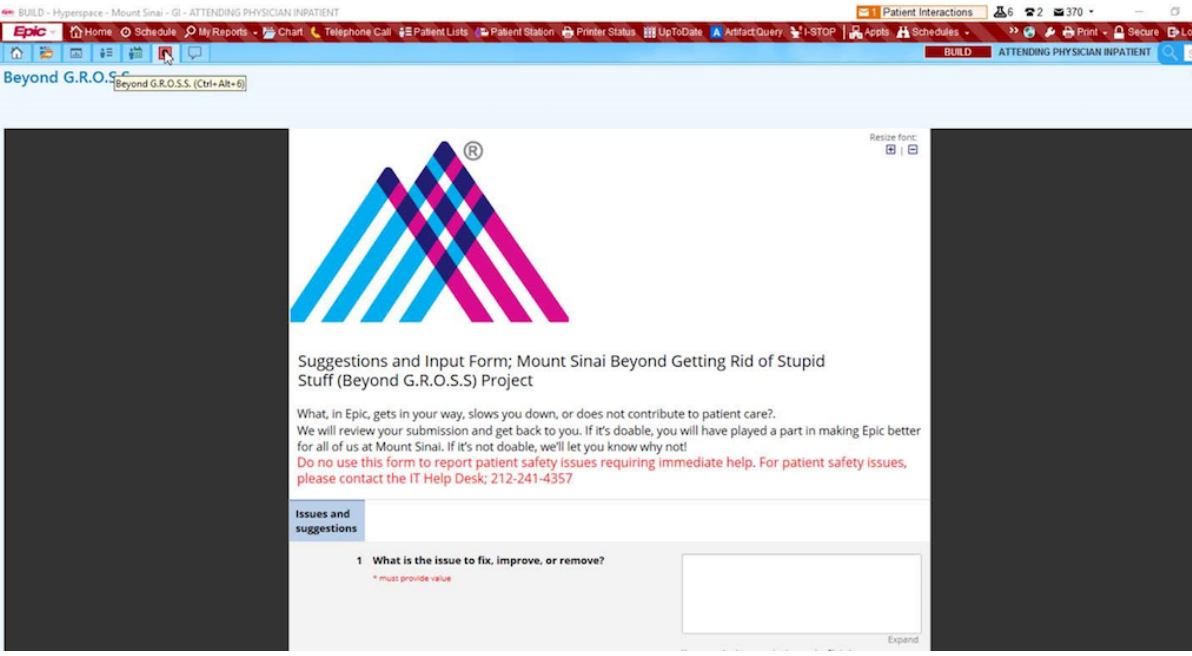
The technicalities involve creating a new activity in text located at the top tab. Parameters like link title and URL were set, and filters were placed limiting the activity to only the Gastroenterology Division. The new activity was also added